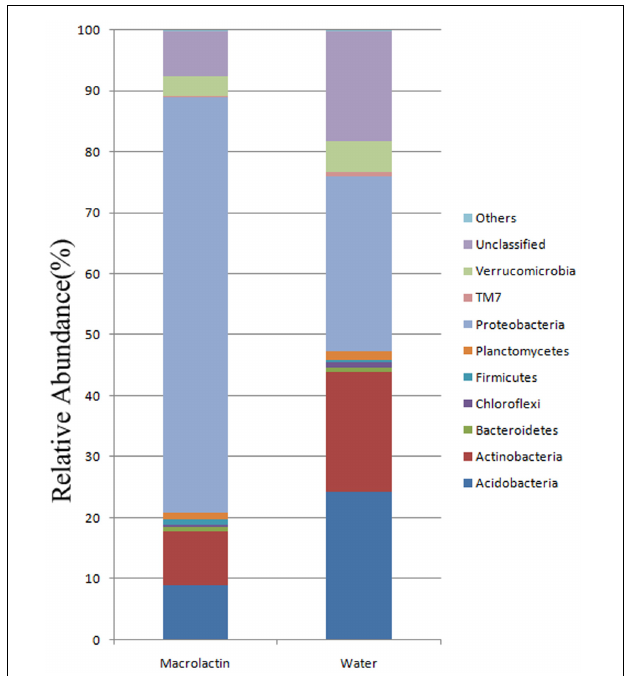
FIGURE 1 | Soil bacterial community composition based on 16S rRNA gene sequencing for macrolactin applied (macrolactin) and water applied (water) soil. Community composition was shown at phylum level averaged for each treatment ( n = 3).